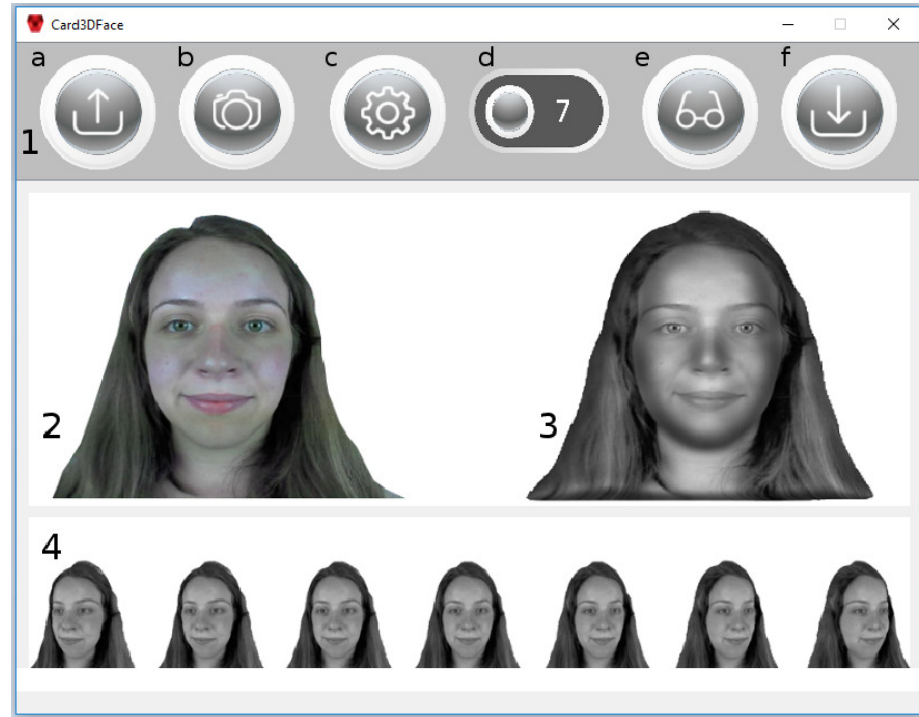
Figure 9. Application